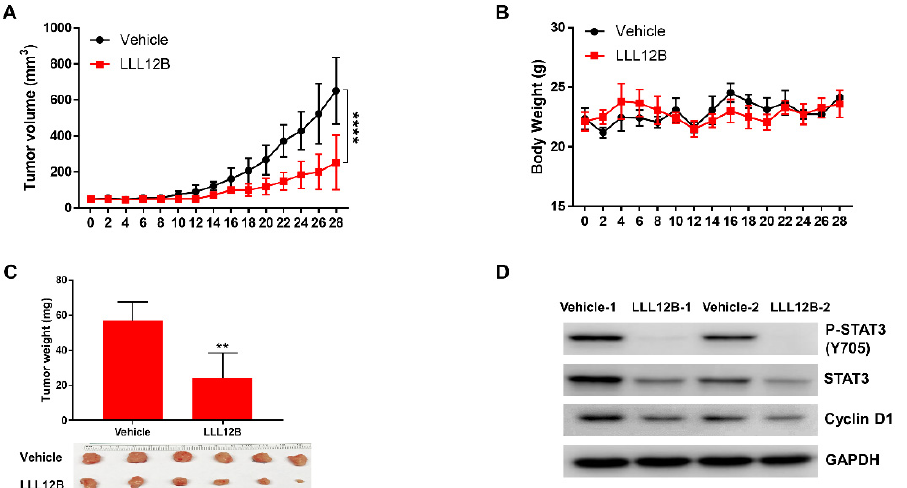
Figure 6. LLL12B suppressed MDA-MB-231 tumor growth in vivo. MDA-MB-231 cells were inocu- lated into the 4th mammary fat pad, and vehicle control or LLL12B (2.5 mg/kg) was administered orally every day for 28 days. ( A ) Tumor volumes were measured every 2 days. ( B ) Body weights were measured every 2 days. ( C ) Tumors were removed after 28 days of treatment and tumor weights were measured. Tumor samples are shown in the bottom panel. ( D ) The expression levels of P-STAT3 (Y705), STAT3, and cyclin D1 in the vehicle- and LLL12B-treated tumor samples were analyzed by Western blot analysis. GAPDH served as a protein loading control. ** p < 0.01, **** p < 0.001.